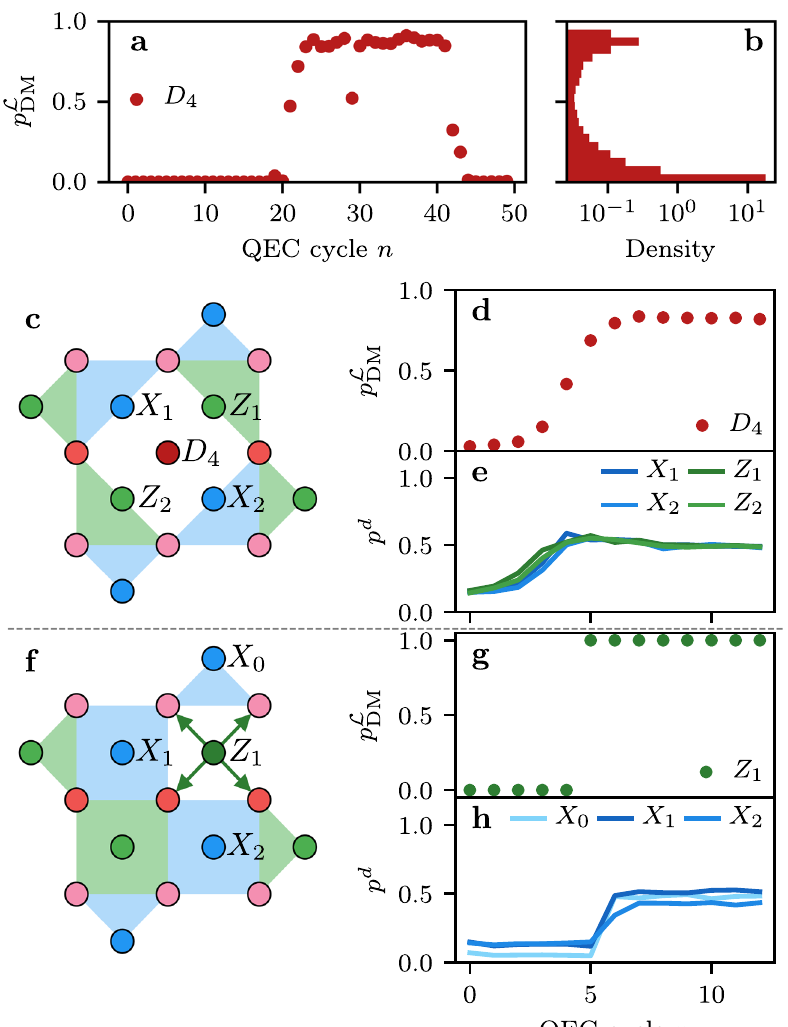
Fig. 3 Projection and signatures of qubit leakage. a – b Projection of data-qubit leakage. a Example realization of a data-qubit leakage event, extracted from the density-matrix simulations. b Density histogram of all data-qubit leakage probabilities over 20 bins, extracted over 4 × 10 4 runs of 50 QEC cycles each. c – e Signatures of data-qubit leakage. c Sketch of how leakage on a data qubit, e.g., D 4 , alters the interactions with neighboring stabilizers, leading to their anti-commutation (see section “ Leakage-induced anti-commutation ” of Supplementary Methods). d The average projection of the leakage probability p L of D 4 over all events, where this probability is fi rst below and then above a threshold DM of p L ¼ 0 : 5 for at least 5 and 8 QEC cycles, respectively. e The average number of defects on the neighboring stabilizers of D 4 over the th selected rounds, showing a jump when leakage rises above p L . f – h Signatures of ancilla-qubit leakage. f Sketch of how leakage on an ancilla th qubit, e.g.,